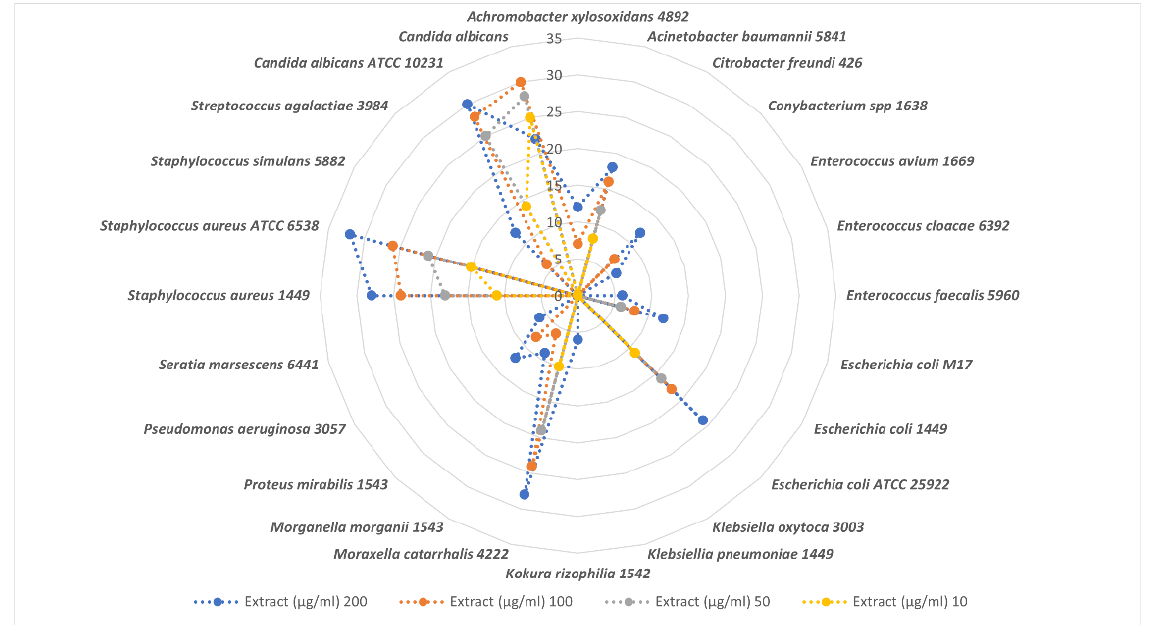
Figure 5. Radar chart obtained from Excel software showing the inhibition diameters of various concentrations of E. Chlorantha bark on the tested strains.